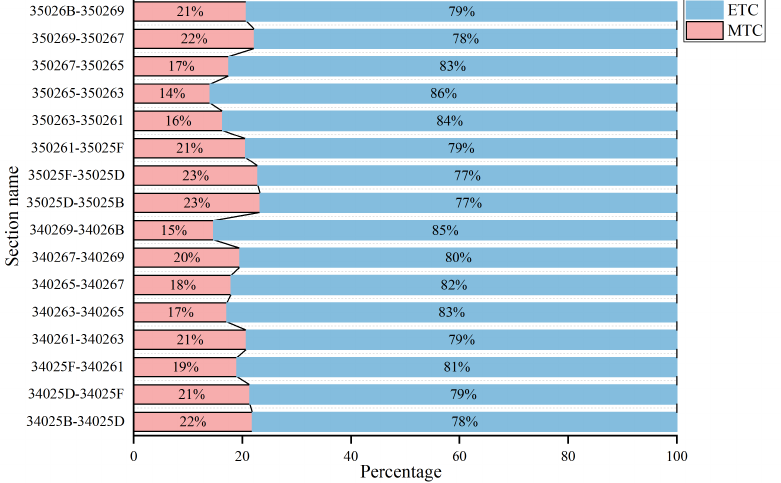
Figure 2. Percentages of ETC transaction data and MTC transaction